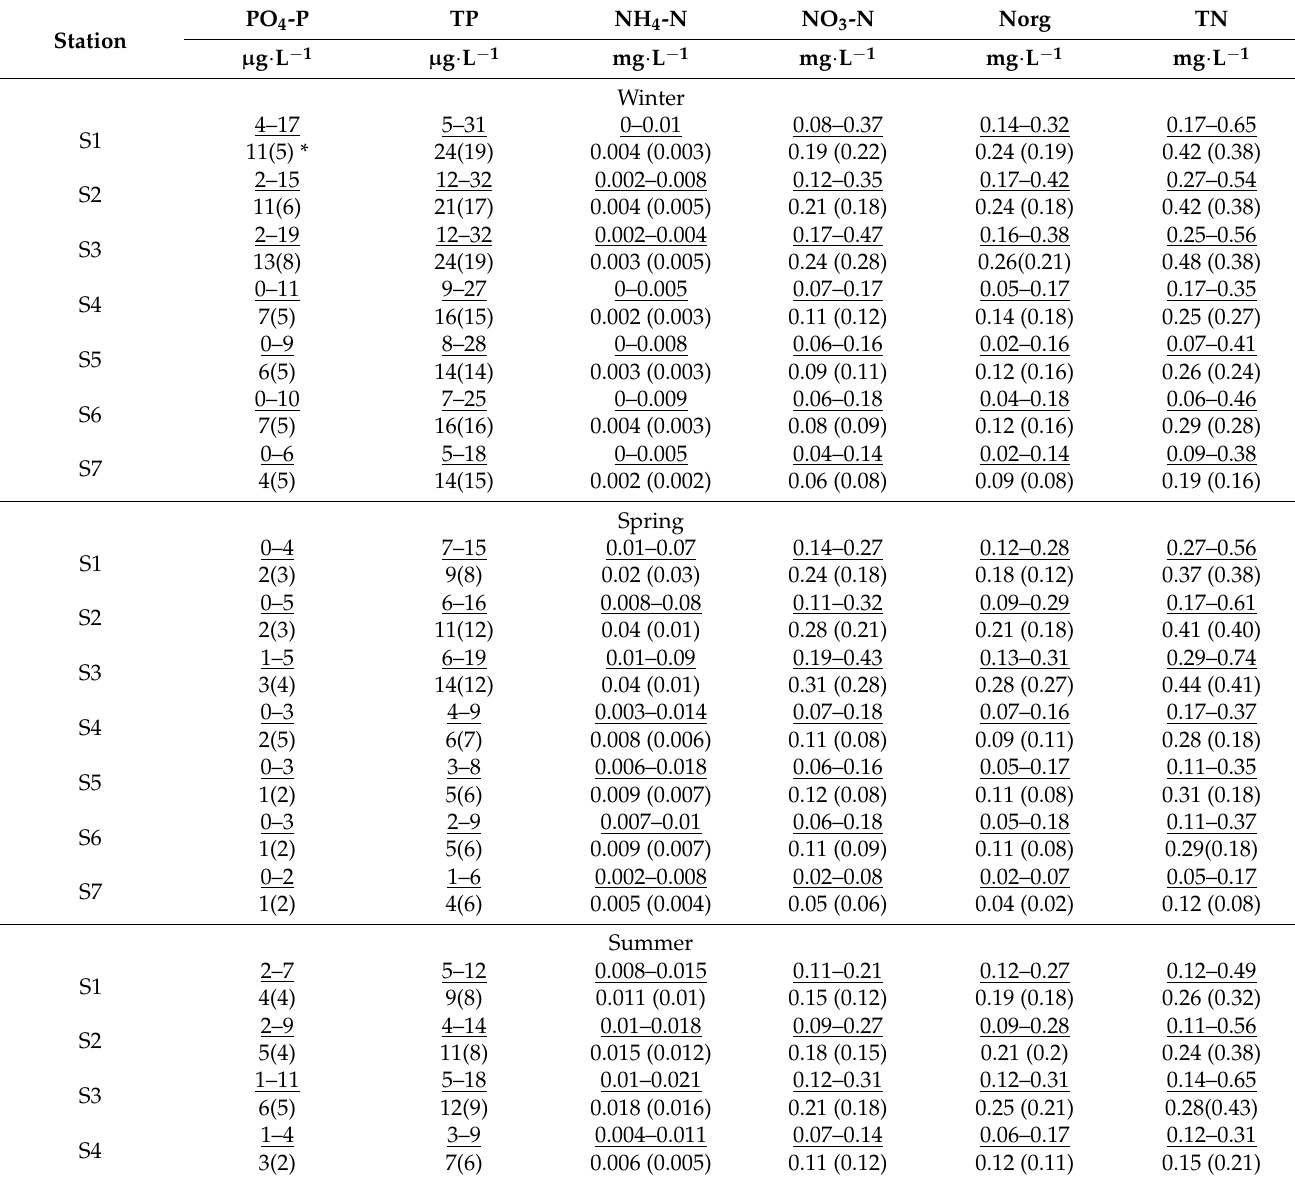
Table 3. Nutrient distribution for Lake Gusinoe waters during